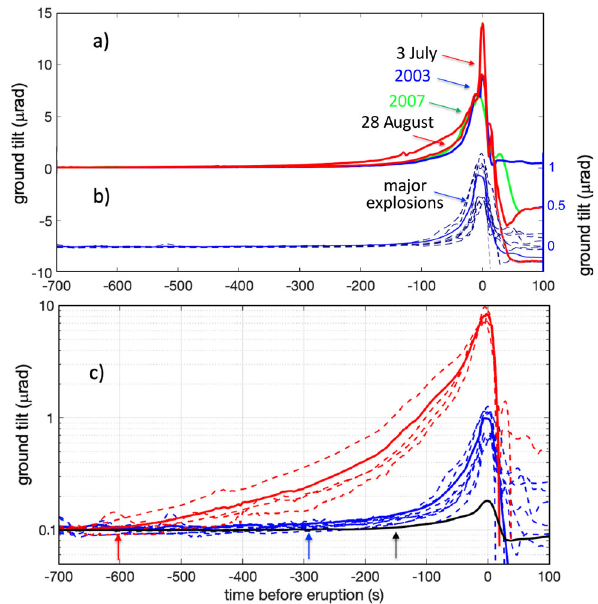
Fig. 2 Comparing tilt for regular, major, and paroxysms eruptions. a Ground deformation associated with the paroxysms of July and August 2019 (red lines), April 2003 (blue line) and March 2007 (green line) in comparison with b the ground tilt recorded during major explosions (dashed blue lines). Note that the ground tilt for the paroxysms and major eruptions have different scales (one order of magnitude) but similar deformation rate. c The different scale of the deformation rate is better evidenced on a semilog scale where the stacking deformation among the four (dashed red lines) paroxysms (bold red line) is represented together 530 with the stacked deformations of major (bold blue line) and regular (black line) explosions 13 . The amplitude of the tilt increases by almost one order of magnitude from regular (~0.1 μ rad) to major explosions (~1 μ rad) and again to paroxysms (~10 μ rad). Note how the exponential rate becomes progressively more evident when the explosive activity becomes more intense and how ground in fl ation becomes visible at ~150 s (black arrow) before a regular explosion, ~300 s (blue arrow) before a major explosion and more than 600 s (red arrow) before a